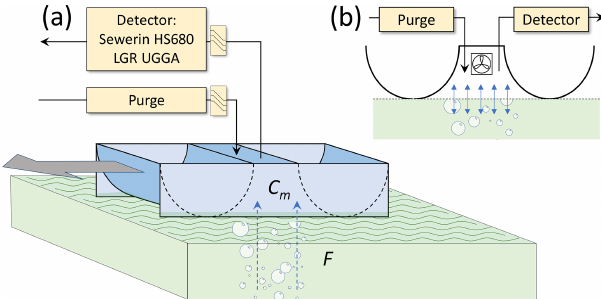
Figure 1. Conceptual sketch of the mobile open dynamic (MOD) chamber, shown at the surface of the lake, passing over an intense seep (a) ; cross section of the chamber cavity (b) . Darker and lighter blue colors indicate three aluminum sheets welded